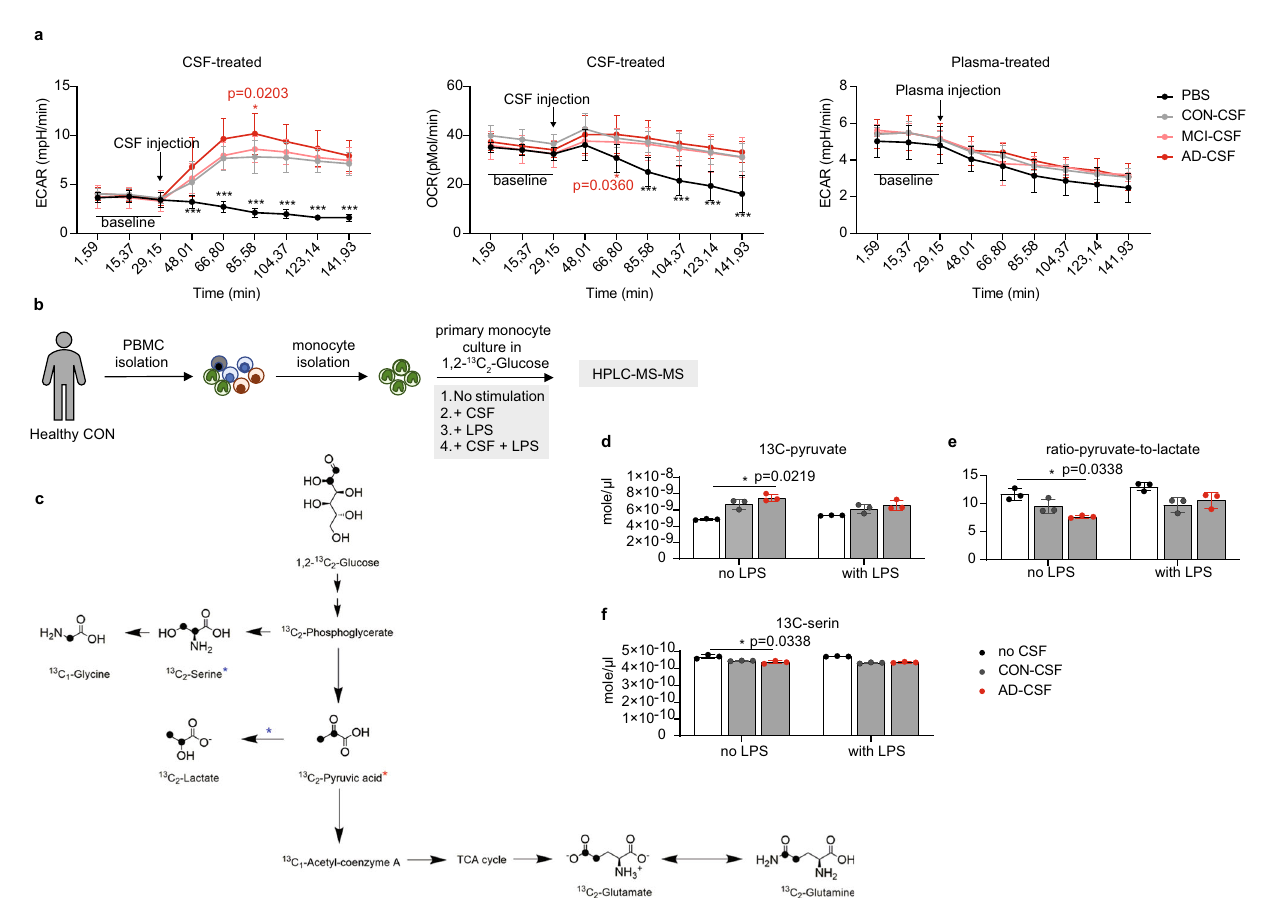
Fig. 2 | Deep immune pro fi ling of human mononuclear cells from blood (PBMCs) and CSF — Panel 2 . Results shown in a – i were obtained from 38 biologi- cally independent PBMCs (CON, n =11; AD, n =8; MCI, n =7 and HD, n =12) and 28 biologically independent CSF samples (CON, n =7; AD, n =5; MCI, n =6 and HD, n =10). a Two-dimensional projections of single-cell data generated by UMAP of PBMCs(greendots)andCSF(pinkdots)cells.Eachdotrepresentsonecell. b UMAP plot of all samples. The colouring indicates 20 clusters representing diverse immune cell phenotypes, de fi ned by the FlowSOM algorithm. c Phenotypic heat- map of cluster identities depicting the expression levels of 12 TYPE markers used for the cluster analysis and 24 STATE markers. Heat colours of expression levels have been scaled for each marker individually (to the 1st and 5th quintiles) (black, high expression; white, no expression). d Frequency plots of the thirteen differ- entially abundant clusters between the CSF and blood compartments. Data